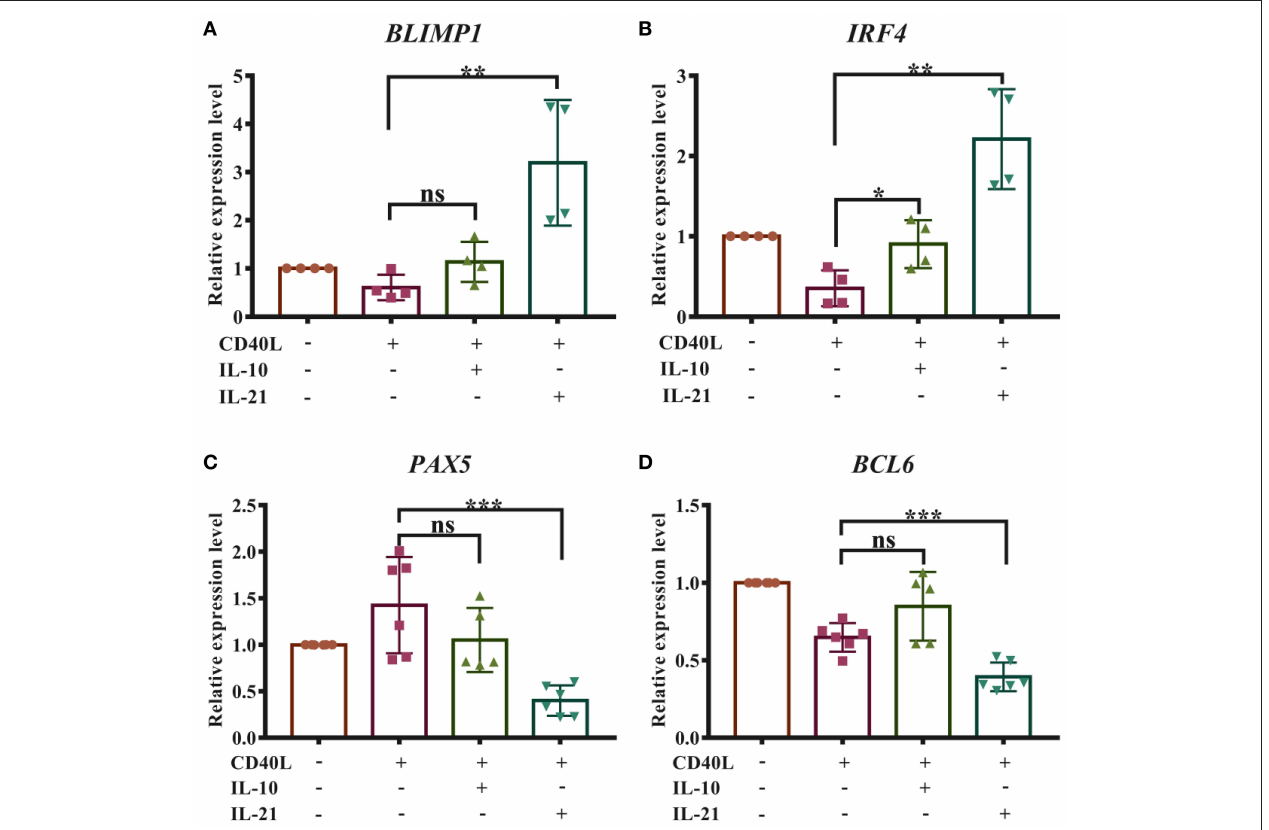
FIGURE 4 | IL-21 facilitates the differentiation of porcine plasma cells. Total RNA was extracted from IgM + B cells after 72h of culture with CD40L/IL-10/IL-21. Real-time quantitative PCR was performed to analyze the relative expression levels of BLIMP1 (A) , IRF4 (B) , PAX5 (C) , and BCL6 (D) , normalized by GAPDH . Cumulative data from three independent experiments were analyzed and presented. ** p ≤ 0.01; *** p ≤ 0.001.